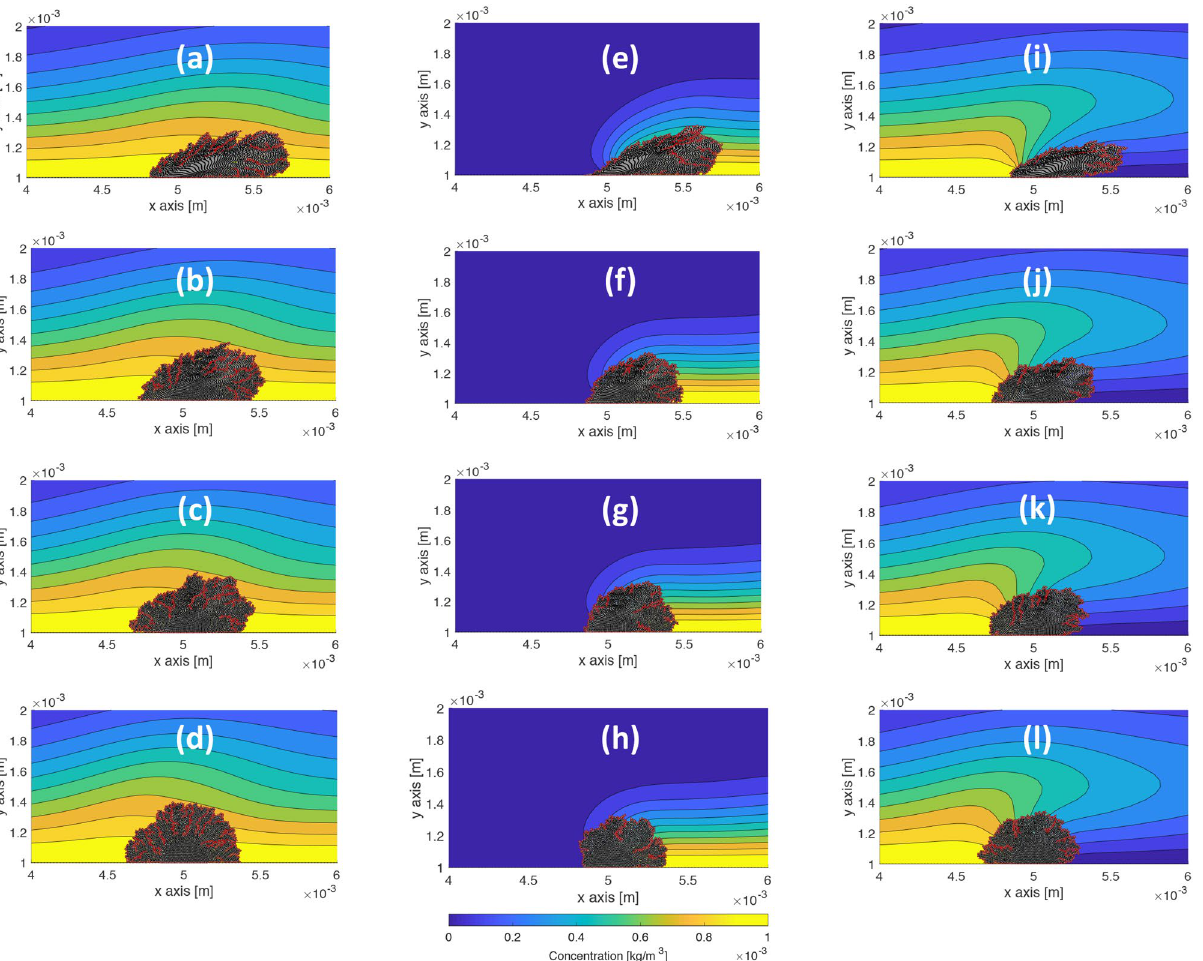
Figure 6. Comparison of growth and deformation of viscoelastic biofilms with three nutrient source configurations and at a shear flow value u max = 5 × 10 − 6 m/s. The red lines indicate the boundary of the biofilm determined with the MATLAB function polyshape. ( a )-( l ) Left to right: full-stream concentration, downstream concentration, upstream concentration; top to bottom: E = 10, 50, 100, 500 Pa. Softer biofilms grow further downstream than the stiffer biofilms in each nutrient